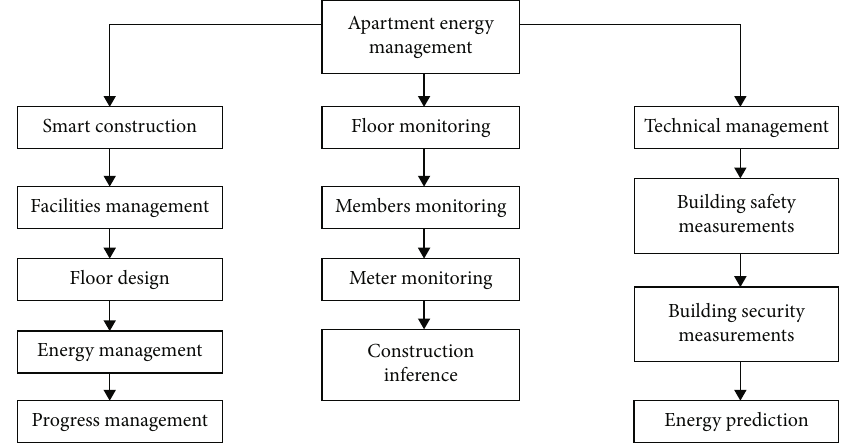
Figure 3: Apartment energy management.